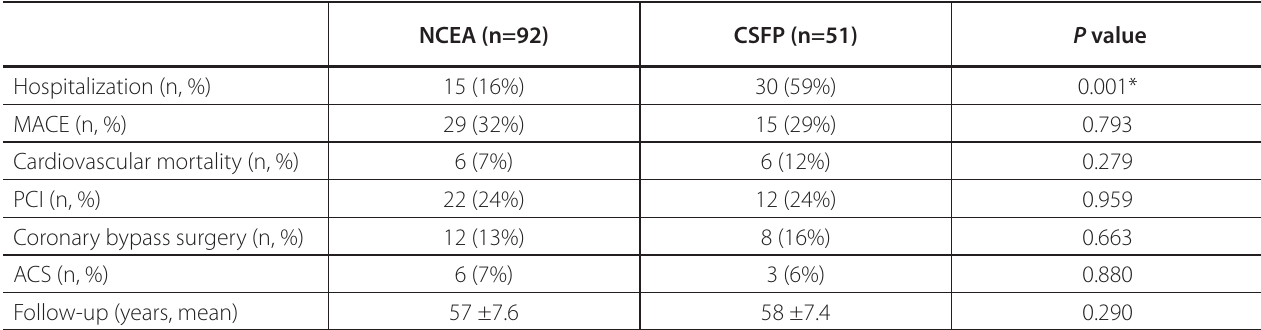
Table 5. Follow-up data of the